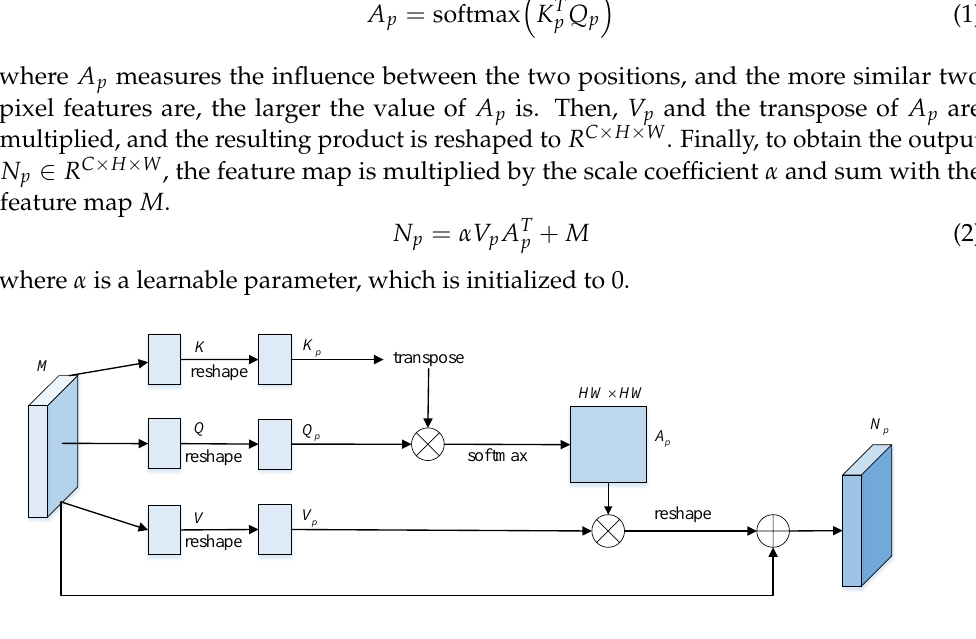
Figure 2. The framework of the position self-attention module